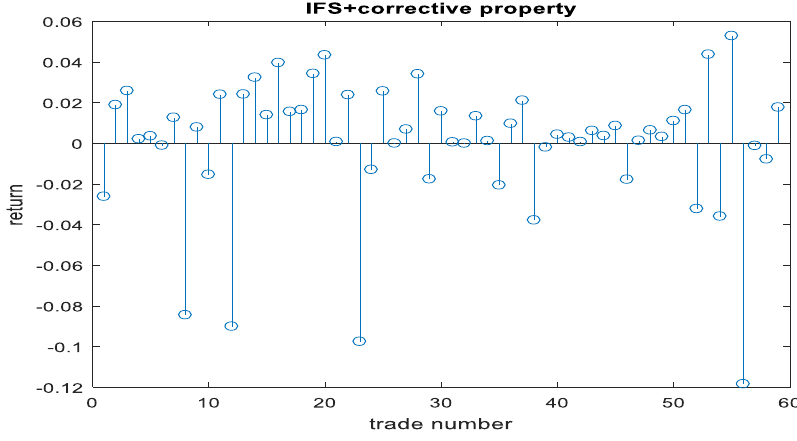
Figure 4. The resulted returns by 59